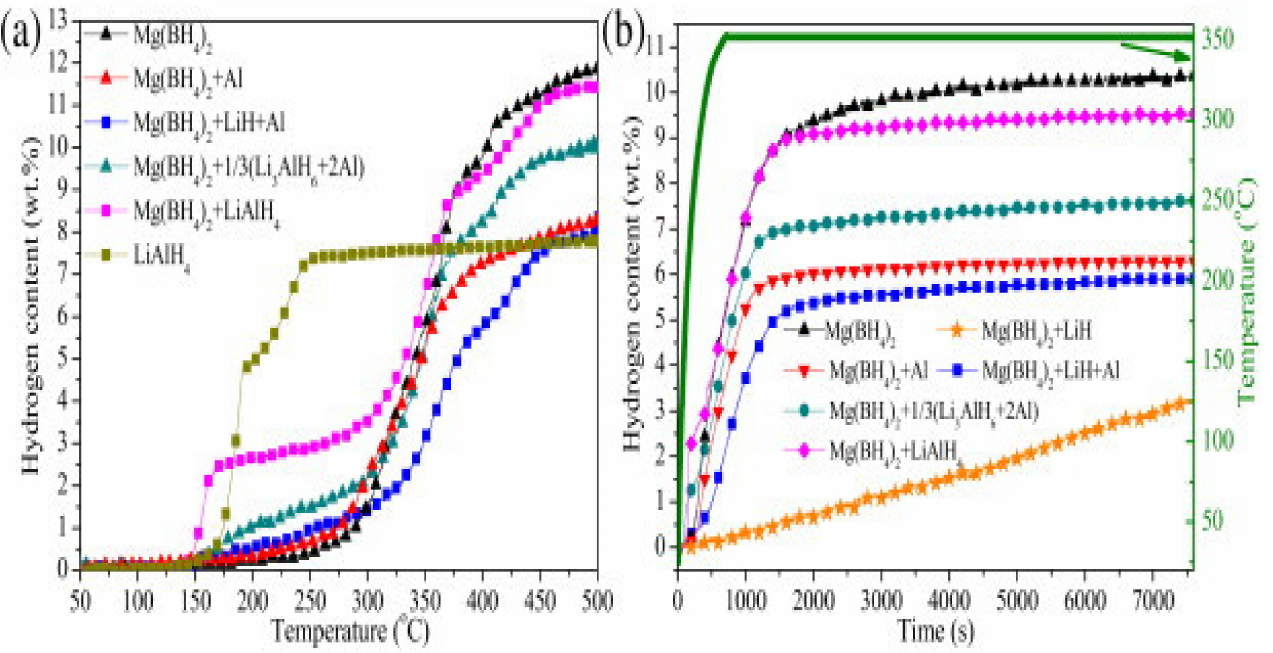
Figure 2. Dehydrogenation properties of the different samples: ( a ) Temperature program desorption curves and ( b ) isothermal desorption kinetics at 350 ◦ C of the Mg-B-Al-H systems